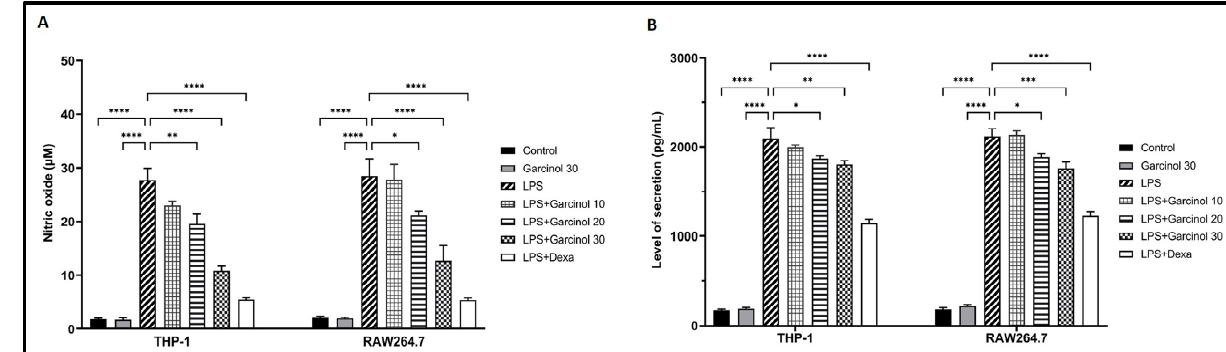
Figure 7. E ff ects of garcinol (10, 20, and 30 µM) on NO ( A ) and PGE2 ( B ) production were deter- mined in LPS-activated THP-1 cells and RAW264.7 cells. The supernatant from the culture media of each group was determined for the NO and PGE2 secretion level by using a Griess test and ELISA, respectively. The data are presented as the mean ± SD of six replicates, examining three independent experiments. For statistical analyses, One-way ANOVA and Dunne tt (cid:31)s test were used. * p < 0.05, ** p < 0.01, *** p < 0.001, **** p < 0.0001.